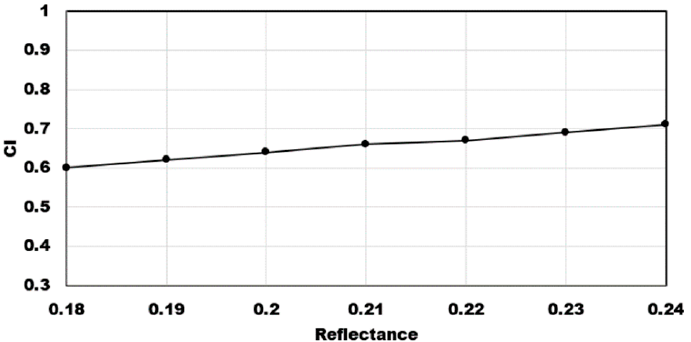
Figure 14. An example of CI-derived GLAS data with different input ground reflectances. As the ground reflectance increases, the CI value increases.